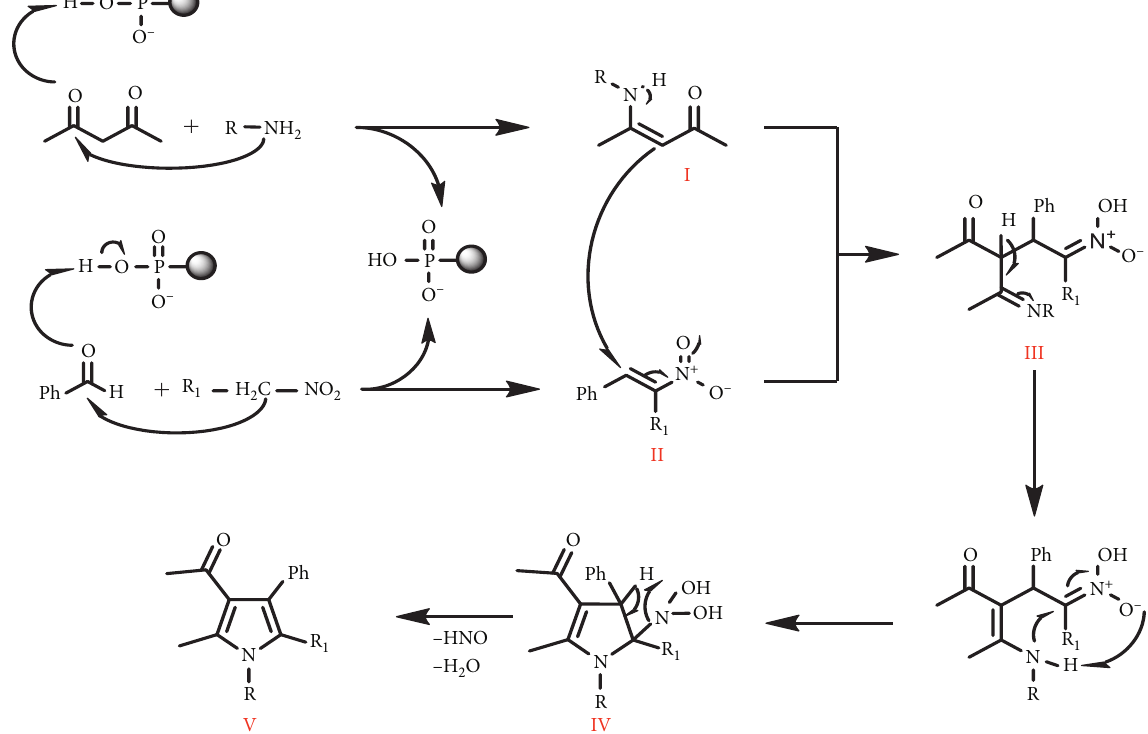
Scheme 5: The mechanism proposed for the synthesis of pyrroles.